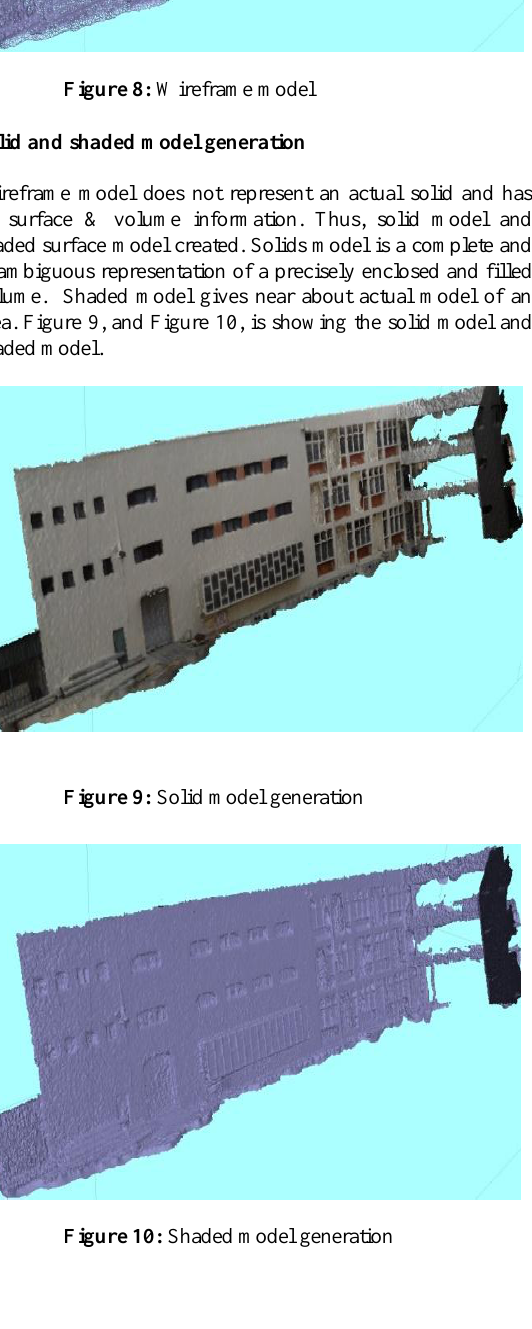
Figure 11: Textured 3D model of building of civil ngineering